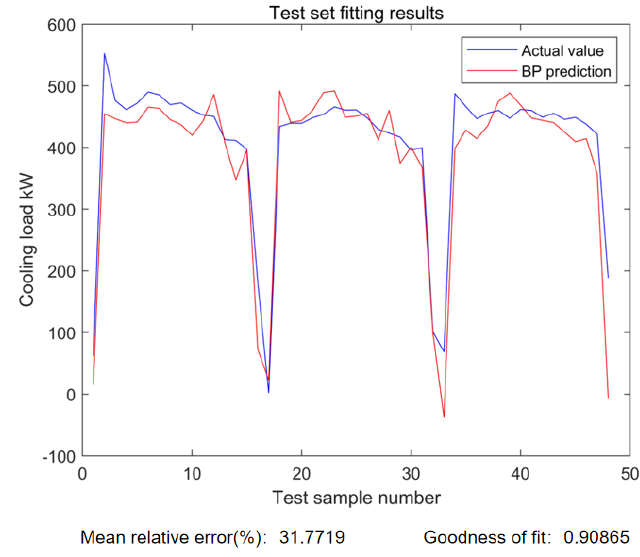
Figure 14. The data-fitted images of the training results.